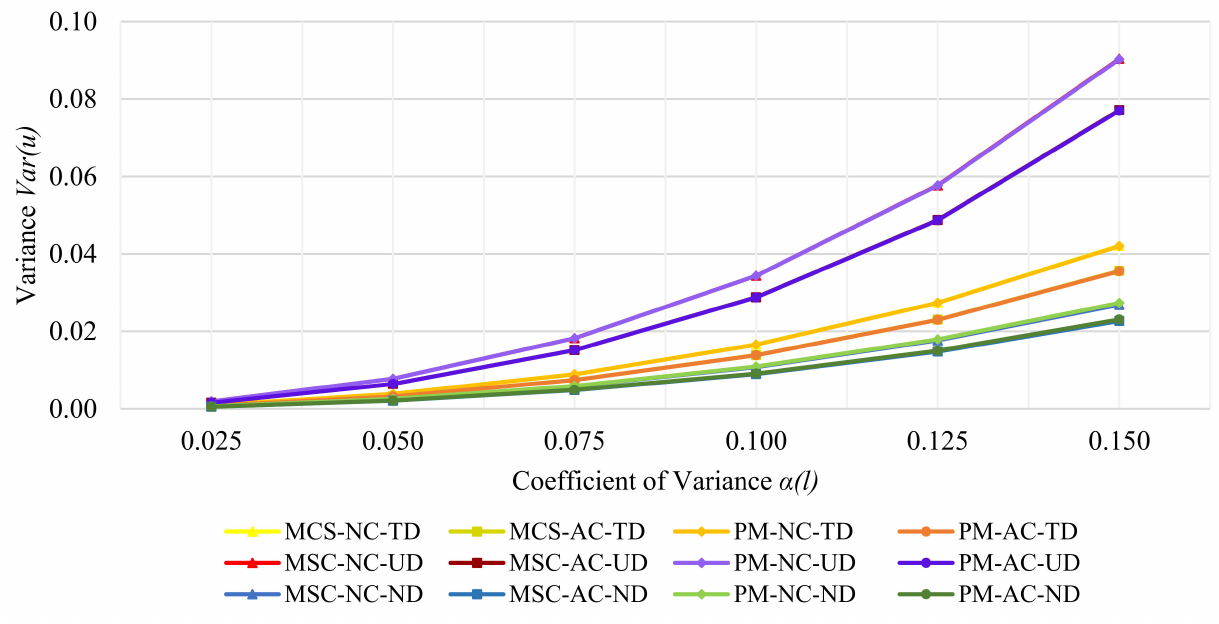
Figure 7. Variance Var ( u ) in the SLS.